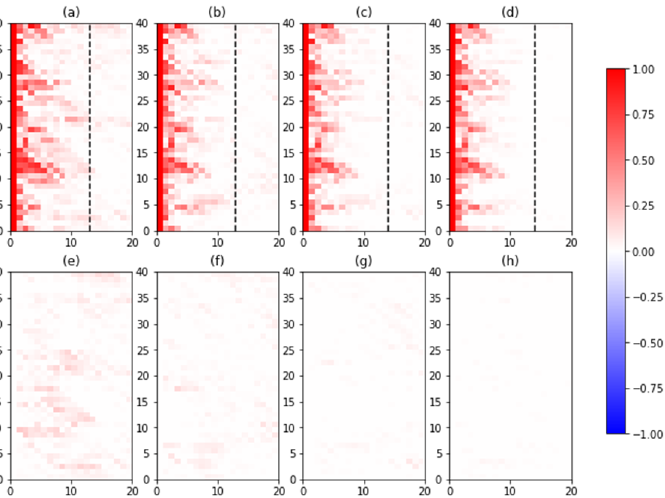
Figure 3. The square of the correlation coefficient in the Lorenz96 model with ( a ) 50 members, ( b ) 100 members, ( c ) 200 members and ( d ) 400 members. ( e – h ) represent the spurious correlation squares,